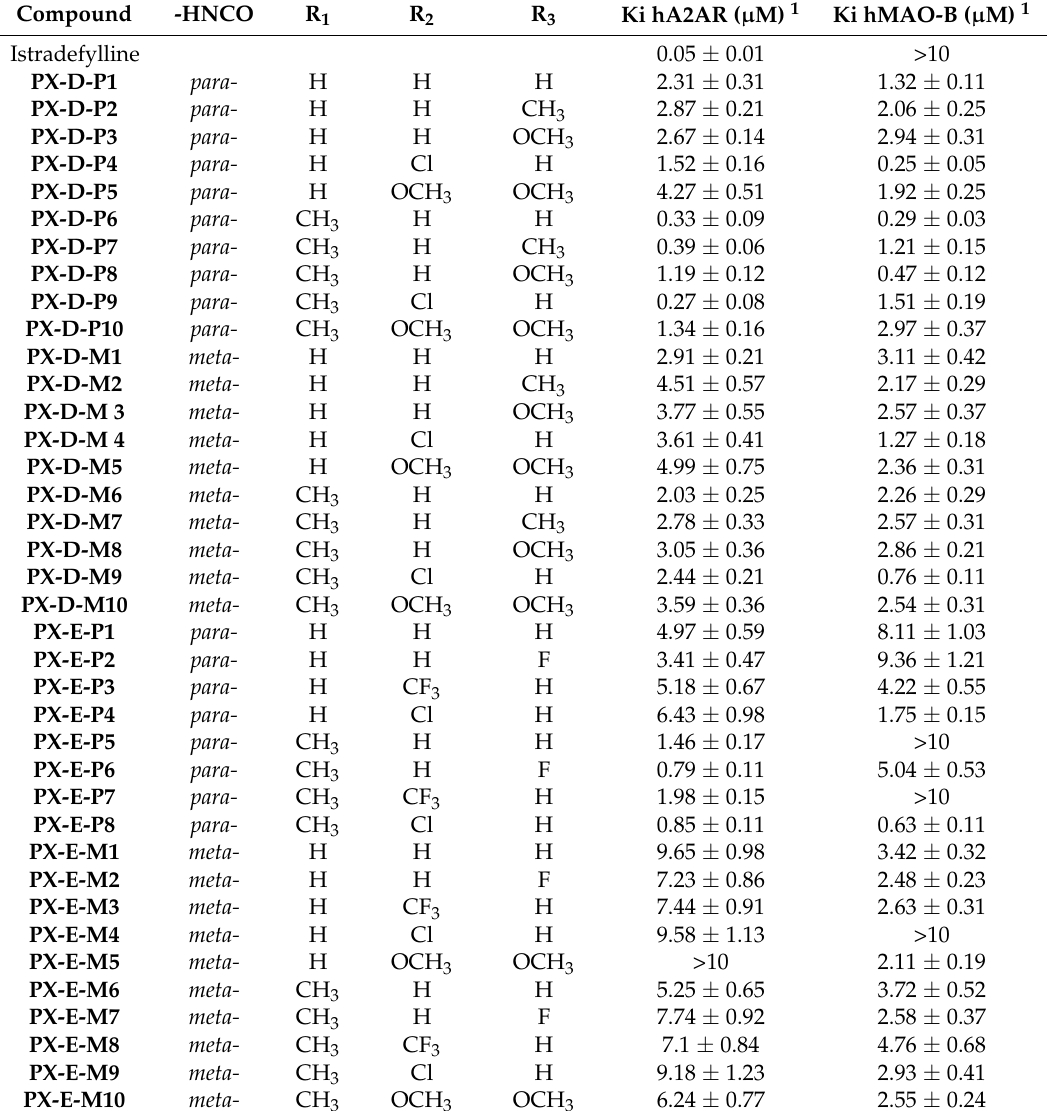
Table 1. Biological data and structure − activity relationship (SAR) of A2AR affinities (Ki) and MAO-B inhibitory potencies (Ki) for test